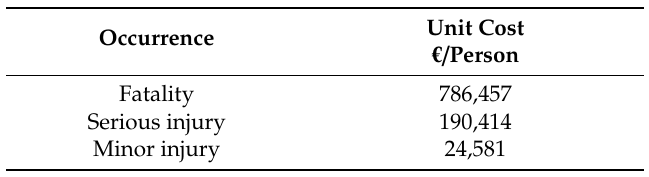
Table 1. Costs associated with